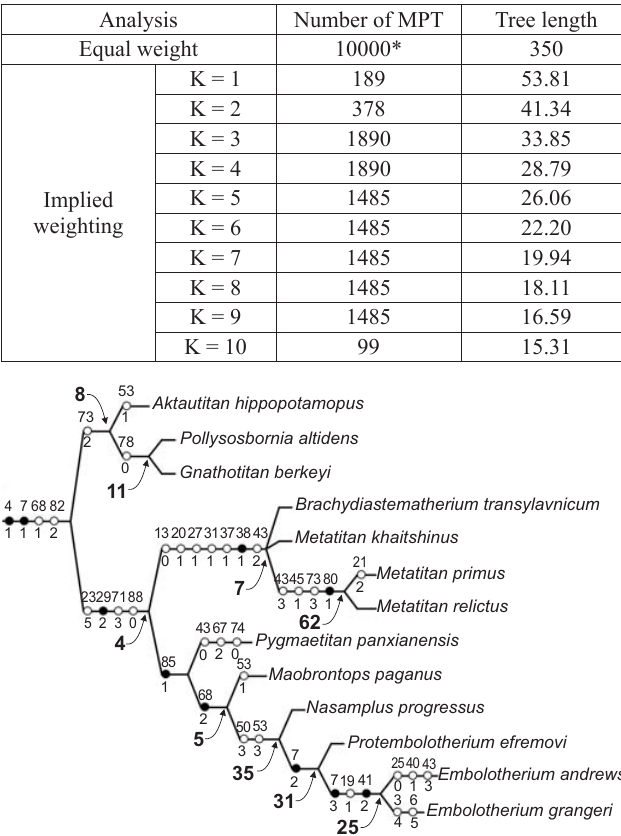
Table 2. Statistics for equal weight and implied weighting analyses. MPT, most parsimonius tree; *